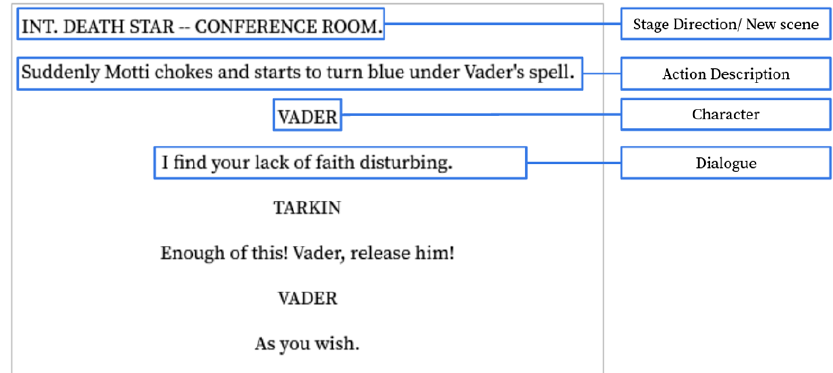
Figure 1. Elements and syntactic structure of a movie script excerpt from Star Wars Episode IV: A New Hope (Lucas,